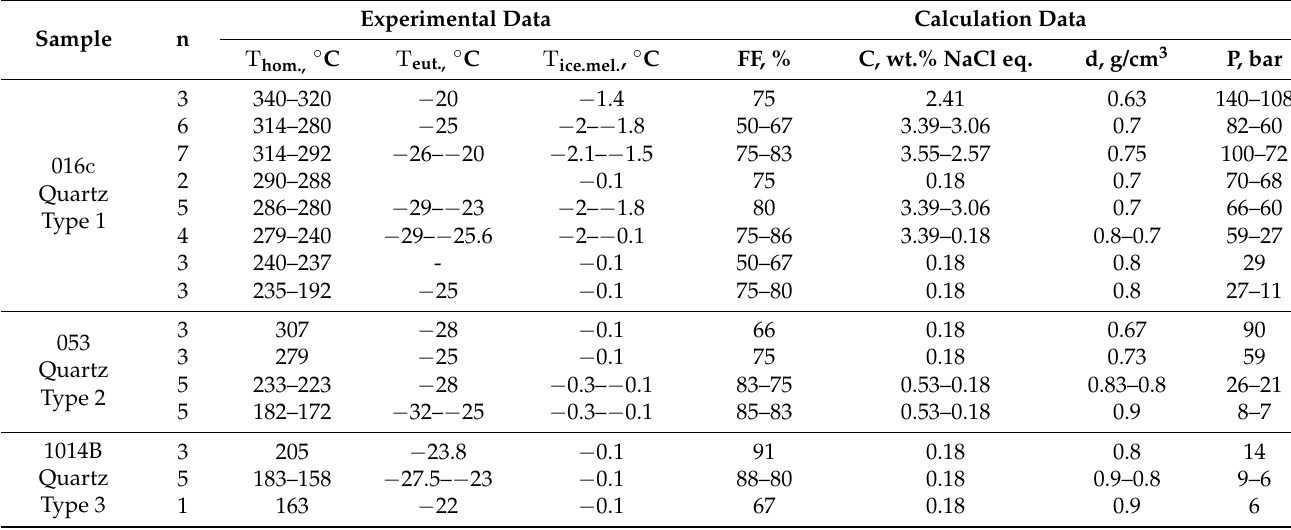
Table 6. Results of microthermometry studies of individual fluid inclusions in the Corrida productive quartz. Experimental Data Calculation Sample n